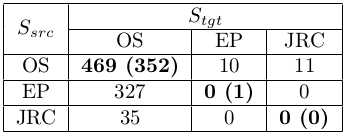
Table from the paper: Monolingual and Cross-lingual Zero-shot Style Transfer
Table text:
S src
S tgt
OS
EP
JRC
OS
469(352)
10
11
EP
327
0(1)
0
JRC
35
0
0(0)